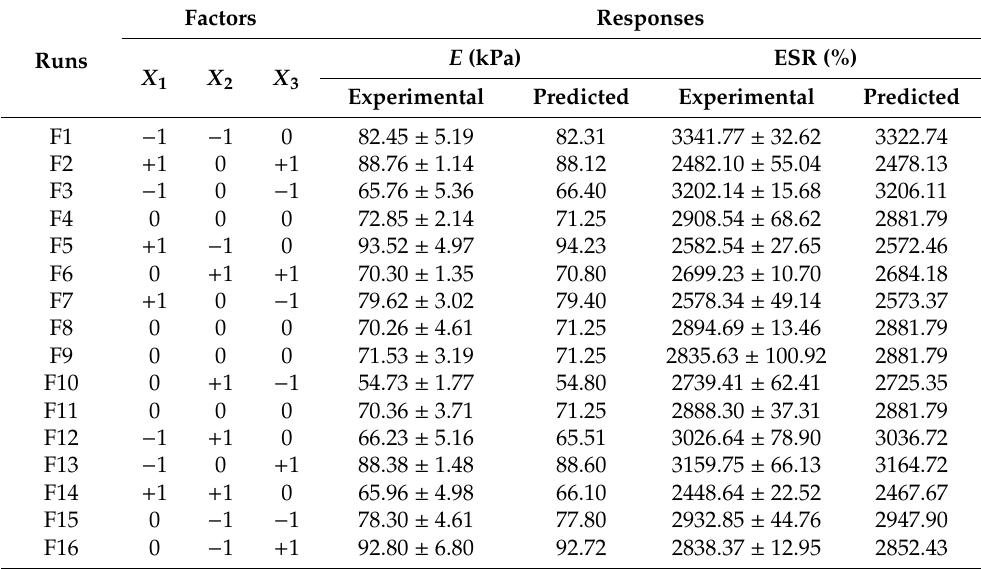
Table 2. Design matrix for the three coded factors with the experimental and predicted responses. Factors Responses Runs Experimental Predicted Experimental